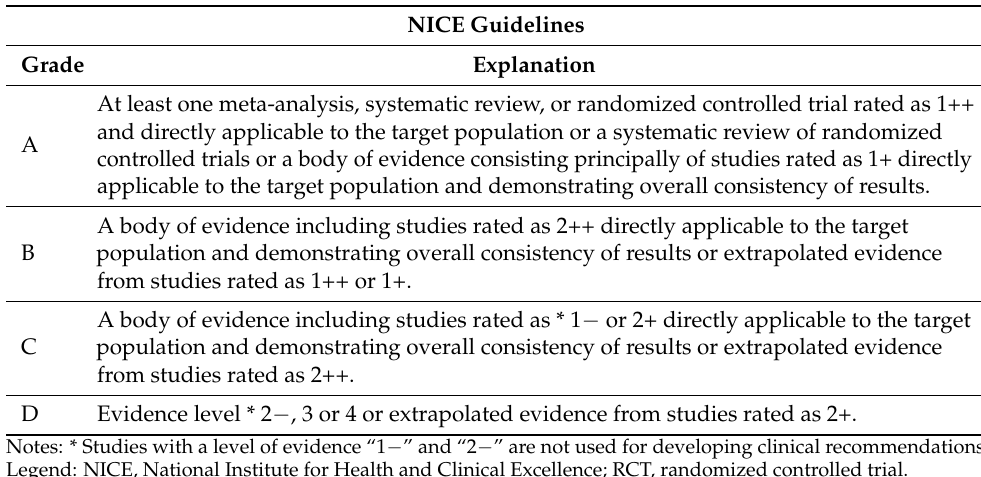
Table A3. Gradings of recommendations according to NICE guidelines